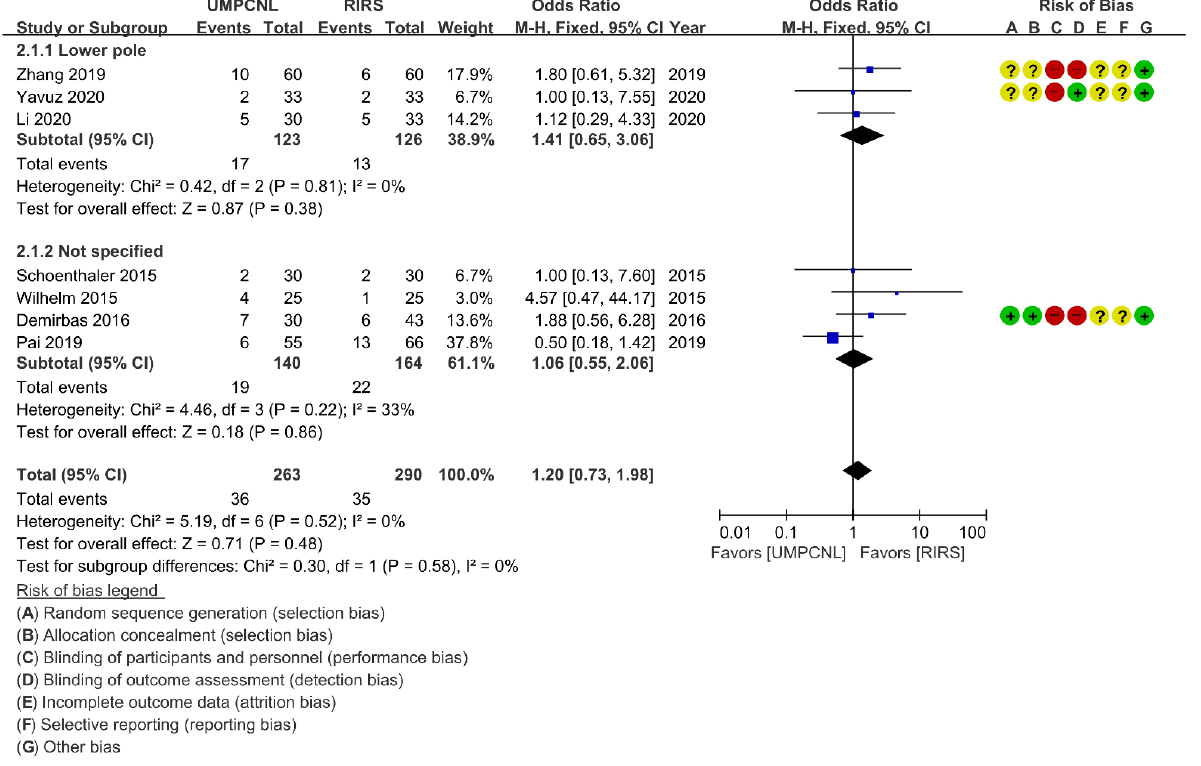
Figure 4. Comparison of UMPCNL and RIRS in terms of the complication rate.